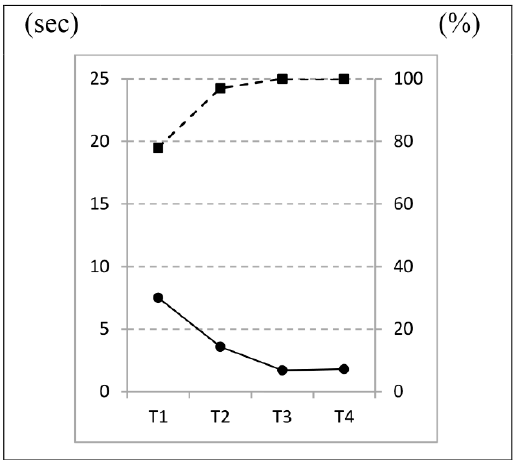
Figure 3. Eye-gaze performance measured at T1–T4. The child’s age was 9 months at T1, 15 months at T2, 20 months at T3, and 26 months at T4. Dotted line: Accuracy (%), Continuous line: Time on task, in seconds (median value).